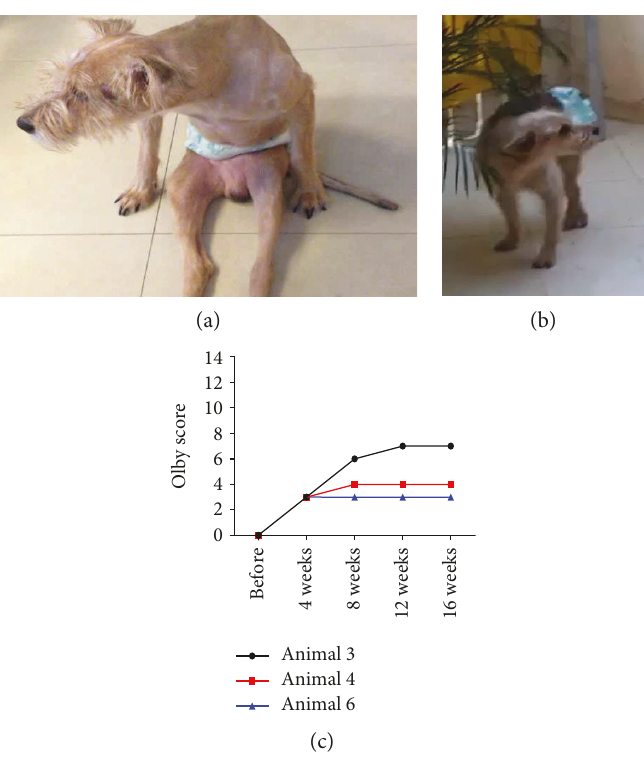
Figure 6: Locomotor function evaluation. Animals were evaluated before and after AT-MSC transplantation by the Olby scale. Animal 3 before (a) and after (b) AT-MSC transplantation. (c) Olby scores obtained for the three dogs that showed functional improvements (animals 3, 4, and